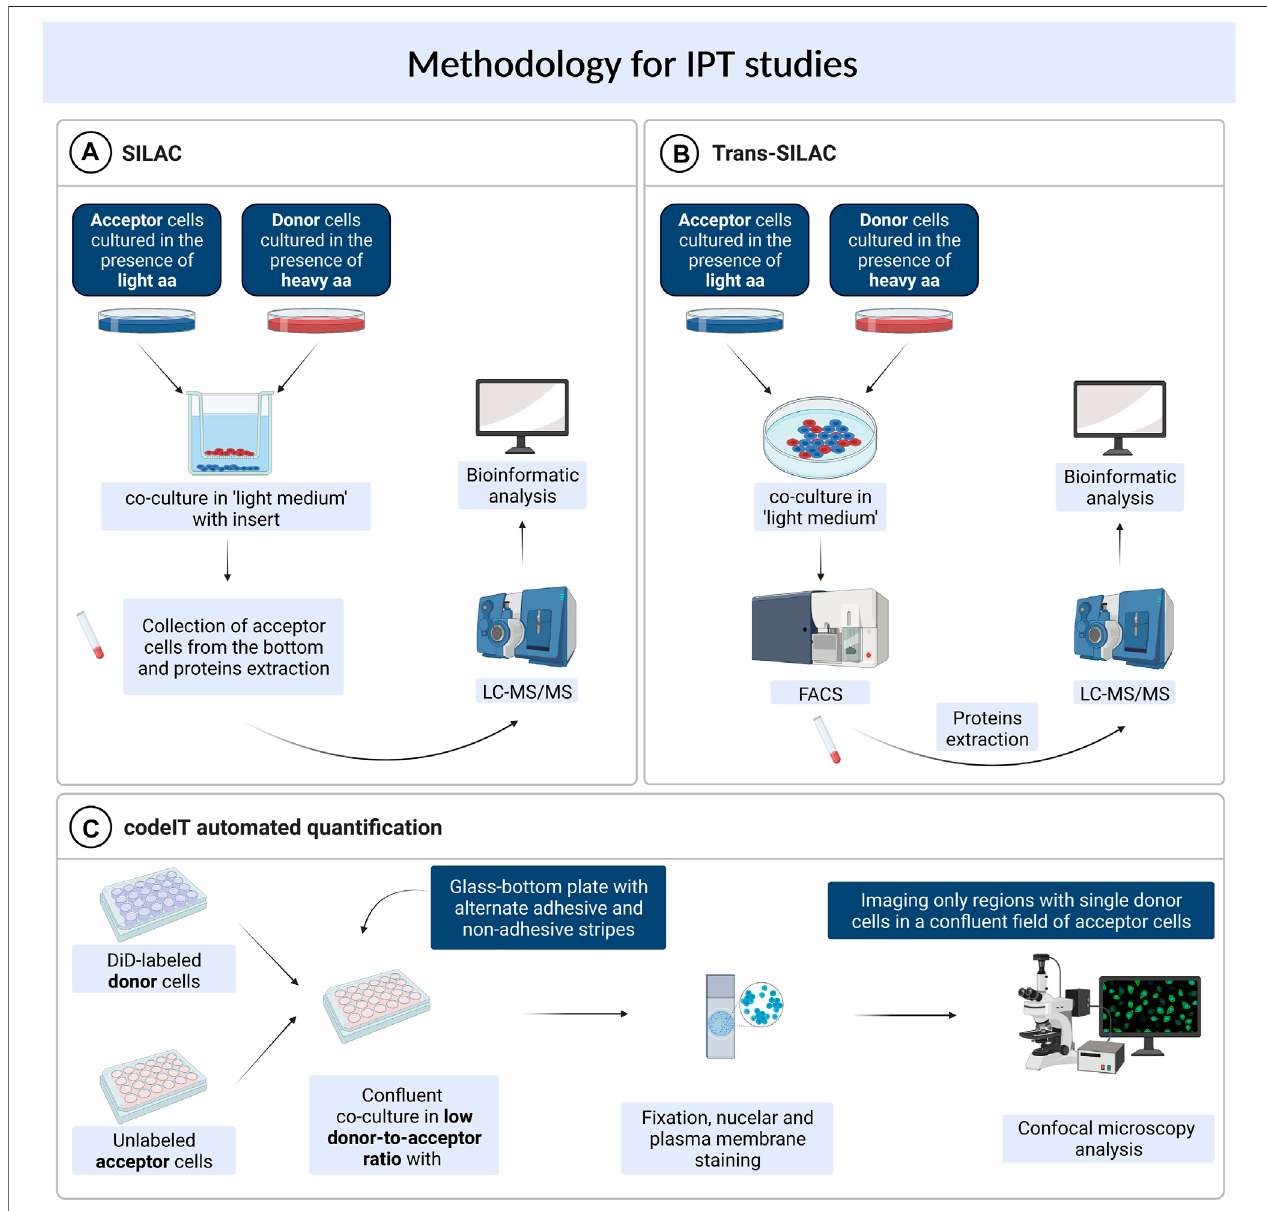
FIGURE 1 | Methods used for studying intercellular protein transfer. (A) SILAC. (B) Trans-SILAC. (C) codeIT automated quanti fi cation.